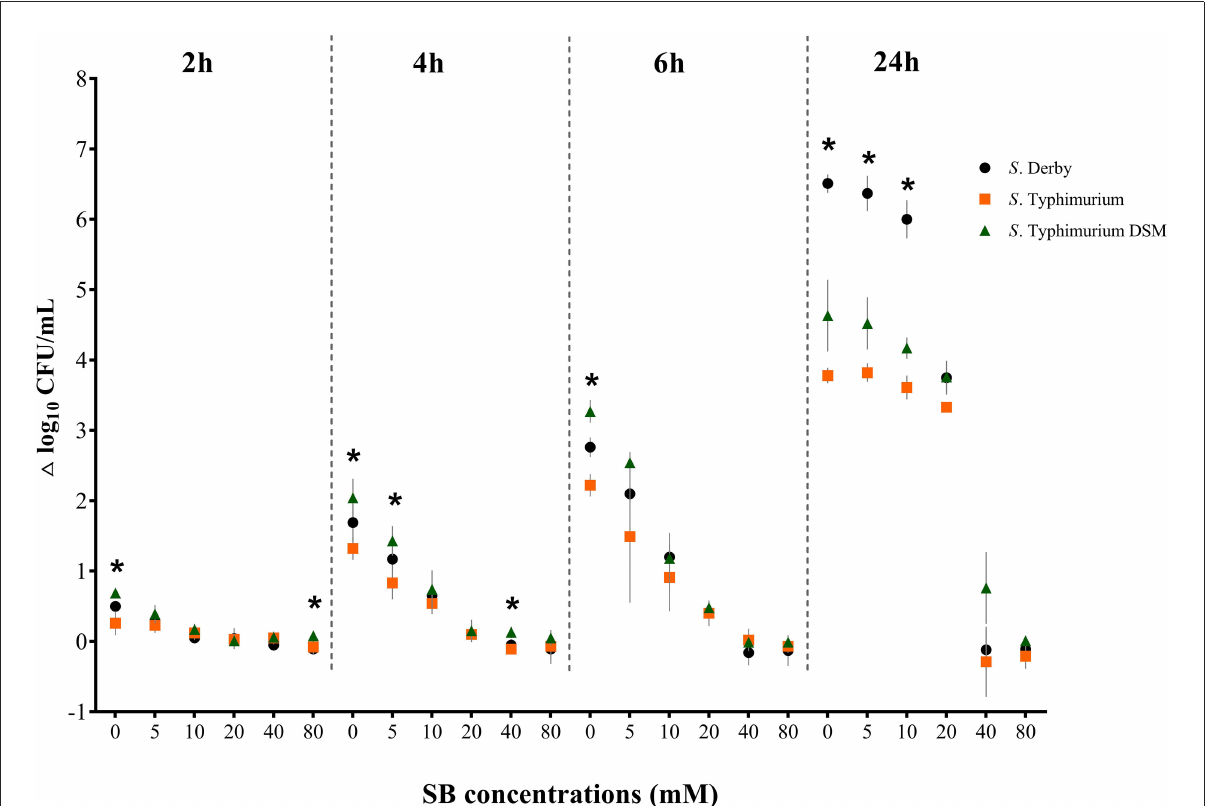
FIGURE6 Growth rate ( 1 log 10 CFU/mL) for the serovars S . Derby (circle), S . Typhimurium (square) and S . Typhimurium DSM 19587 (triangle) for three consecutive trials ( n = 3) for sodium butyrate (SB) concentrations 0, 5, 10, 20, 40, and 80mM divided by incubation duration 2, 4, 6 and 24h; * indicates significant difference between serovars ( p <